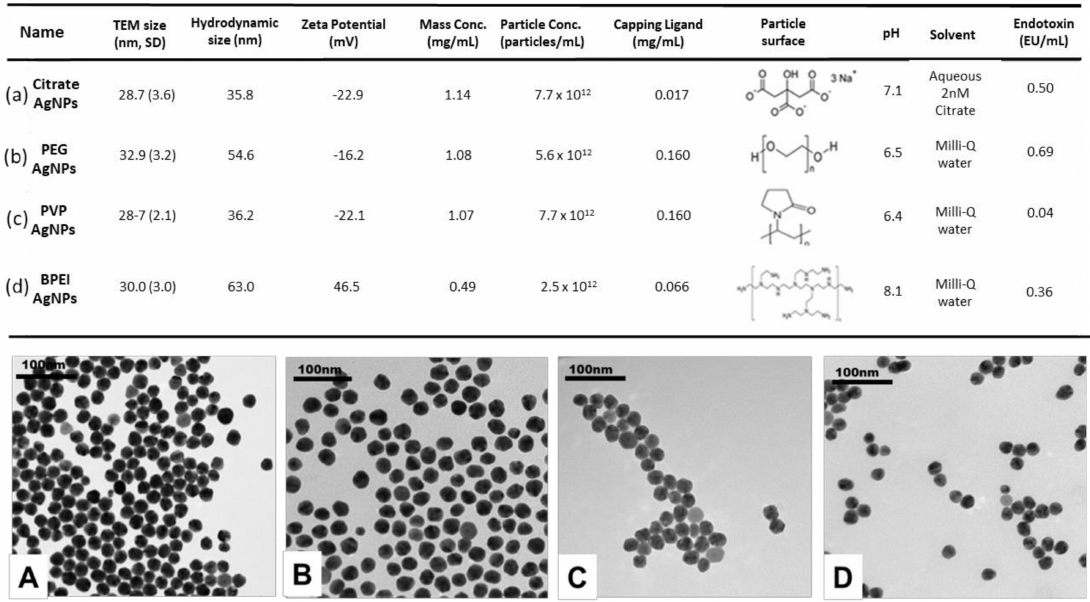
Figure 1. Characterization of silver nanoparticles (AgNPs). ( a – d ) Physicochemical properties of Citrate AgNPs, polyethylene glycol (PEG) AgNPs, polyvinylpyrrolidone (PVP) AgNPs, and branched polyethyleneimine (BPEI) AgNPs in stock suspensions. ( A – D ) TEM images of surface-modified AgNPs